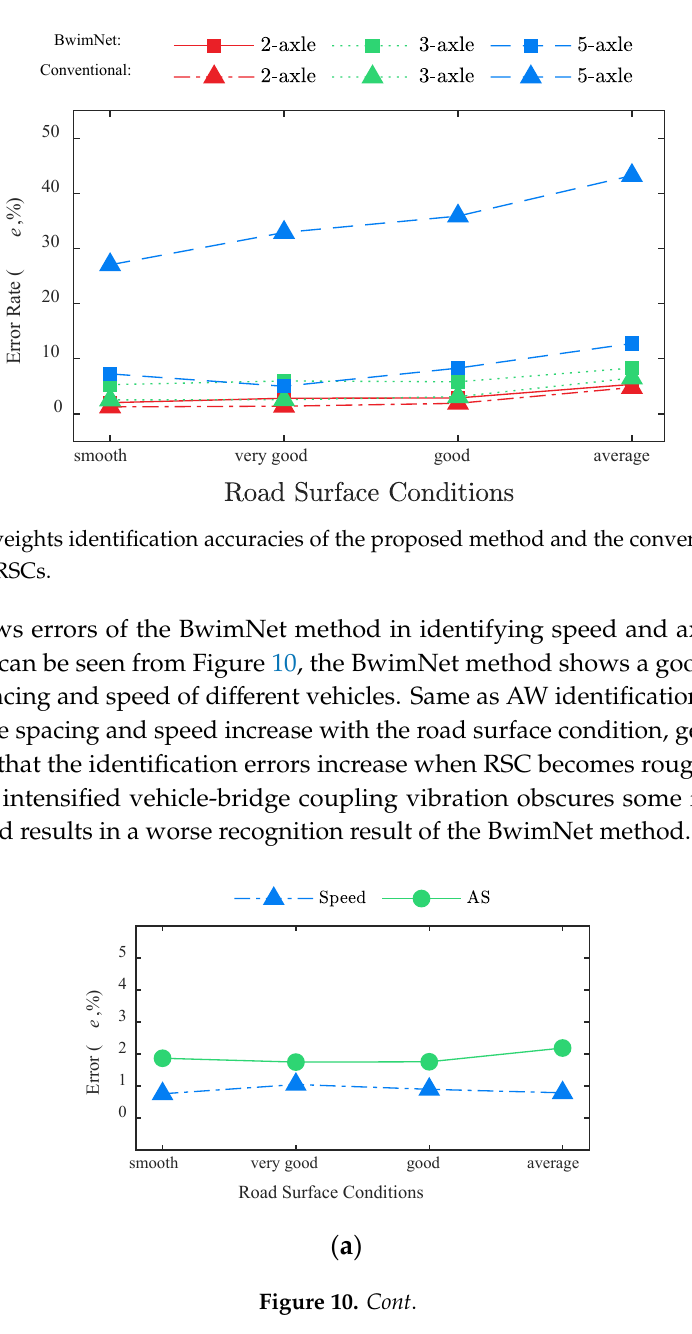
smooth very good good average